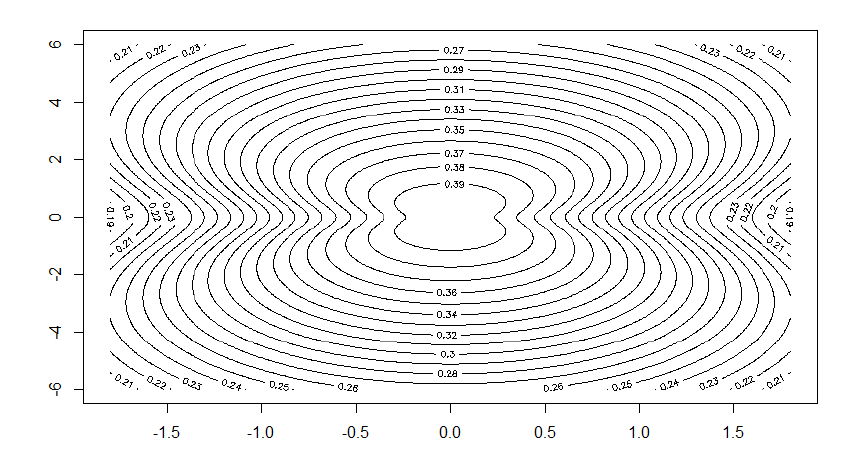
Figure 4. Contour plot of the density of ϕ g , K , µ for a = − 0.8 and levels 0.39, 0.38, · · · 0.19.